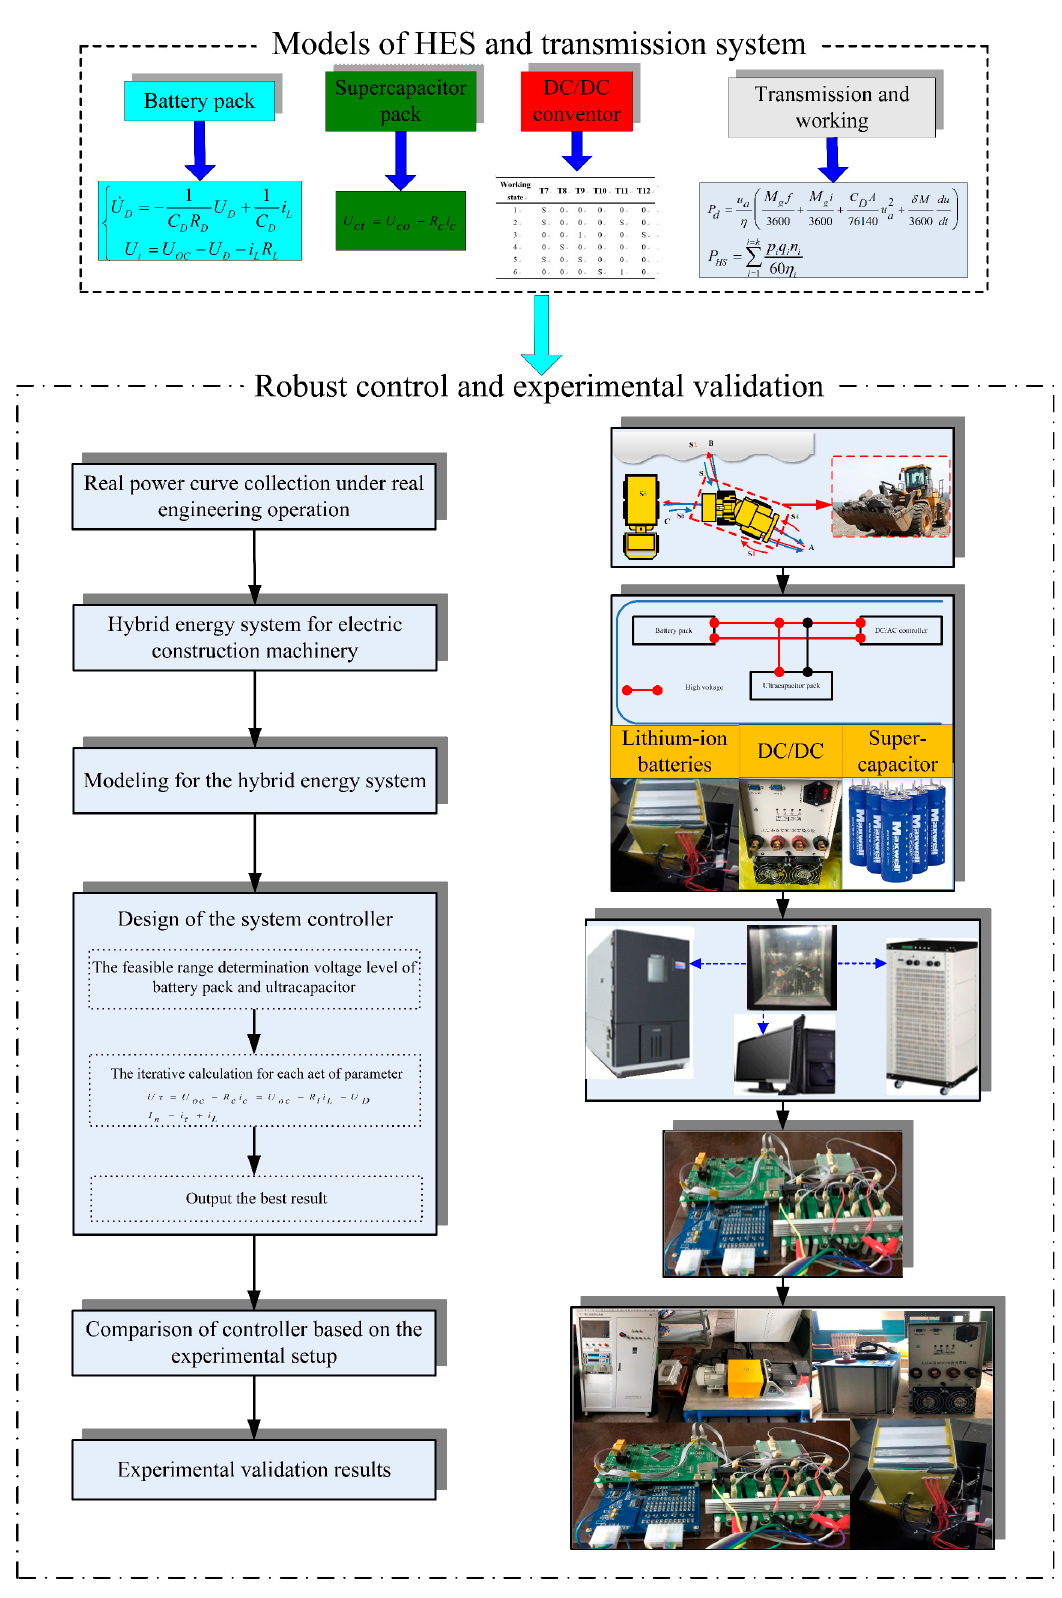
Figure 3. The framework of the proposed